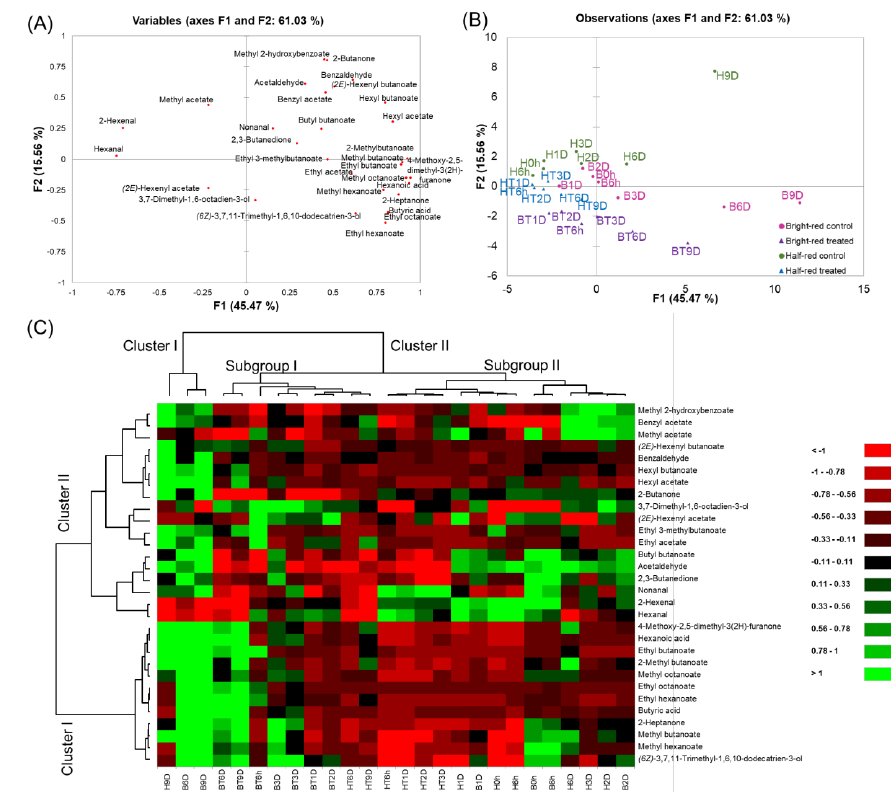
Figure 4. ( A ) Score plot, ( B ) loading plot of the principal components analysis, and ( C ) hierarchical clustering and heatmap visualization of the changes in the volatile compounds in strawberries during storage. (H: half-red, B: bright-red, T: CO 2 treated, h: hours, D: days). Green and red colors presented in the heatmap indicate values above and below the mean centered and scaled expression values, respectively. Black indicates values close to the mean. The total number of features was the same as the number of determined volatiles in the strawberries (n = 30), and the “non-specific filtering” option in the XLSTAT program was not used. Missing data were estimated using the nearest-neighbor algorithm. Hierarchical clustering was conducted based on Euclidian distances.